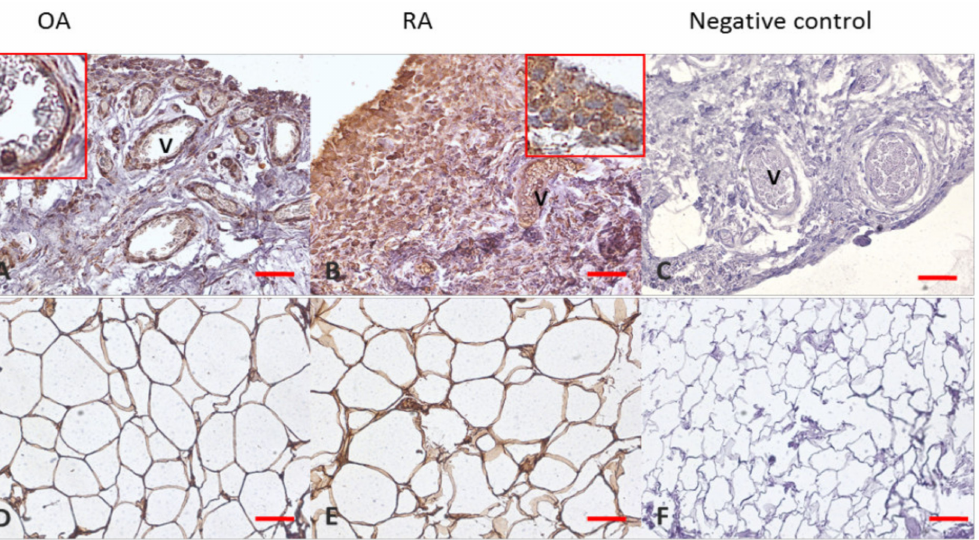
Figure 4. Adiponectin expression in joint’s tissues. Panels ( A – C ) synovial membranes; Panels ( D – F ) Hoffa’s fat pad. OA—osteoarthritis; RA—rheumatoid arthritis; V—vessel; Panels ( C , F ) show negative control staining. Objective magnification × 20, scale bar 50 µ m; only representative images are presented. Insets show large magnifications of cytoplasmic staining in synovial membrane cells (Panel ( B )) and endothelial cells (Panel ( A